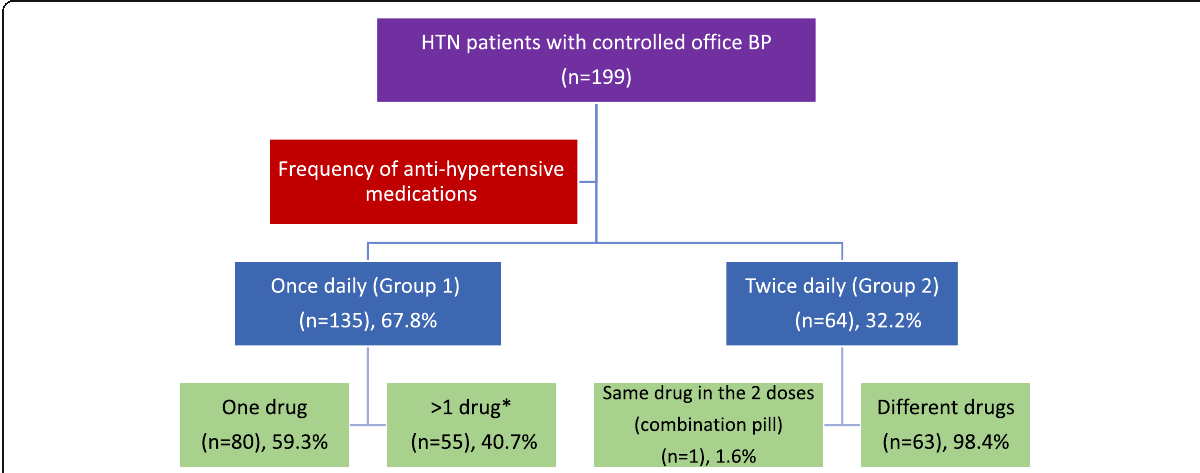
Fig. 1 Distribution of the study population. *One combination pill or separate